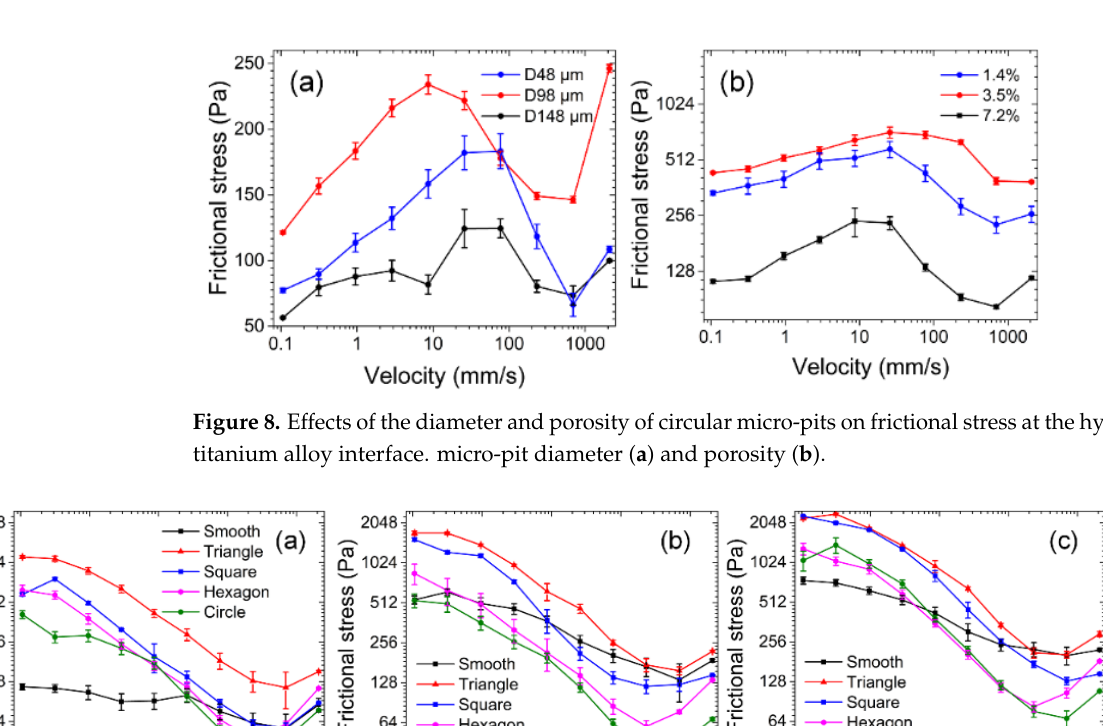
Figure 8. Effects of the diameter and porosity of circular micro-pits on frictional stress at the hydro- gel – titanium alloy interface. micro-pit diameter ( a ) and porosity ( b ).